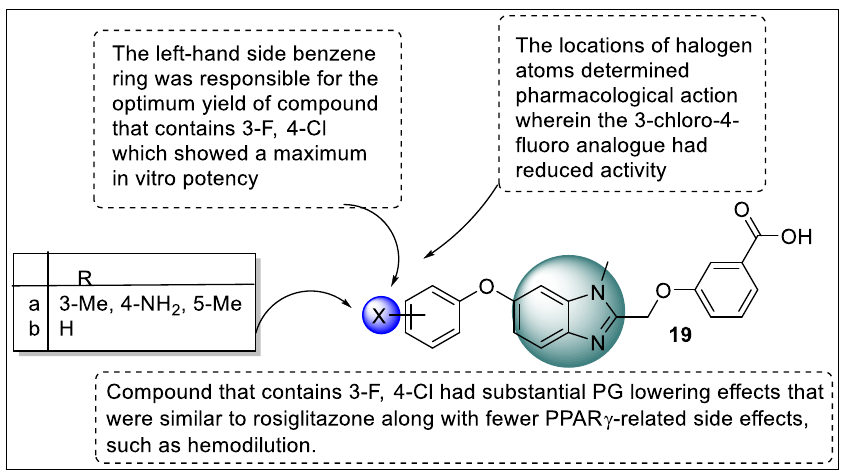
Figure 22. Structural activity relationship of Benzimidazole hybrids ( 19 ) as potent PPAR ligands.